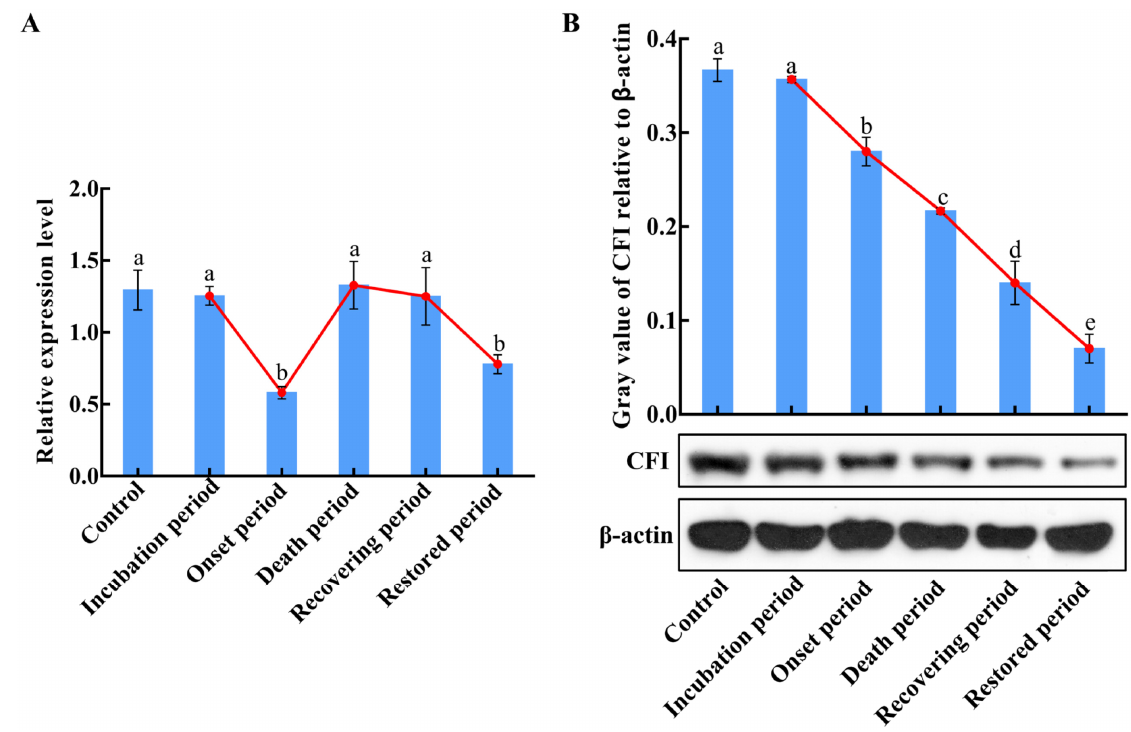
Figure 8. The mRNA and protein expression level changes of CiCFI in the liver of grass carps after GCRV infection. Letters a, b, c, d, and e indicate significant differences among the expressions in the liver at various periods post-GCRV infection ( p < 0.05). ( A ) The mRNA expression level changes of CiCFI in the liver of grass carps after GCRV infection. ( B ) The protein expression level changes of CiCFI in the liver of grass carps after GCRV infection.